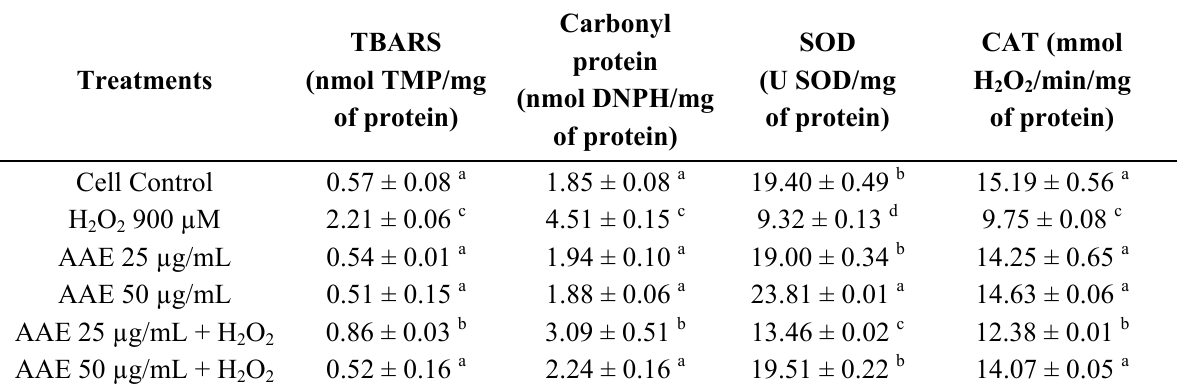
Table 2. Determination of the thiobarbituric acid reactive substances (TBARS), carbonyl protein, superoxide dismutase (SOD), and catalase (CAT) activities in the MRC5 cells pretreated with the extract of bracts of A. angustifolia and H